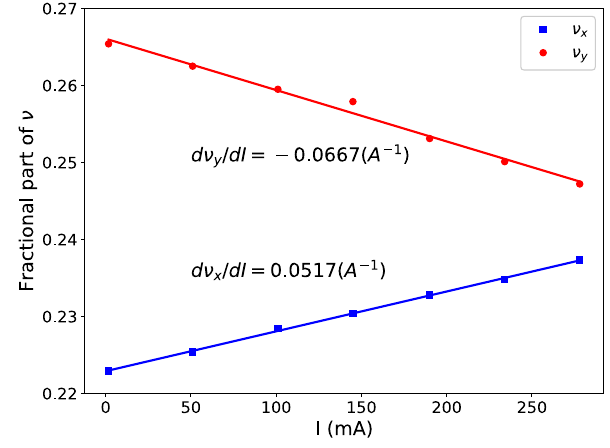
FIG. 8. Tune shifts with stored beam